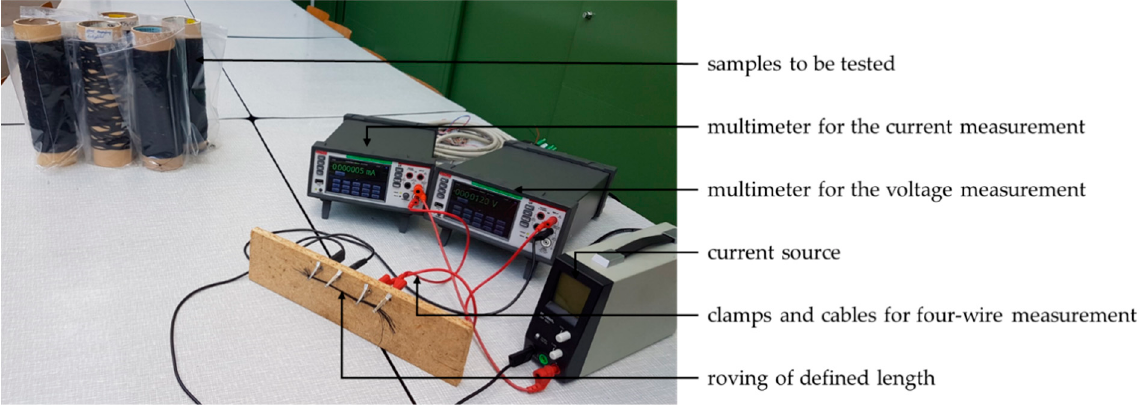
Figure 2. Test setup for the determination of electrical resistance.